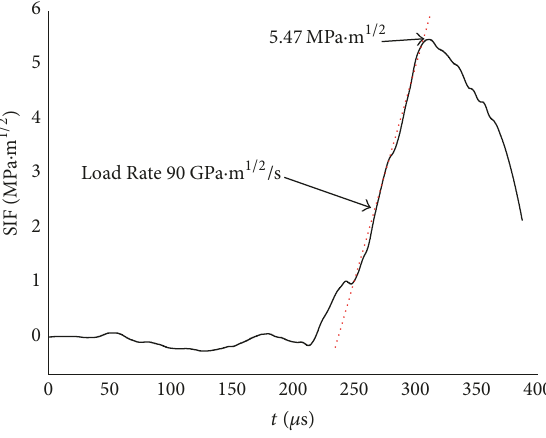
Figure 5: SIF time-history